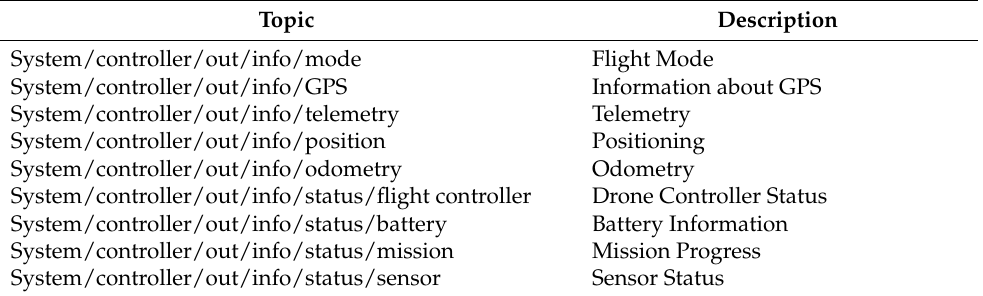
Table 3. Data transmitted from the device in real time.